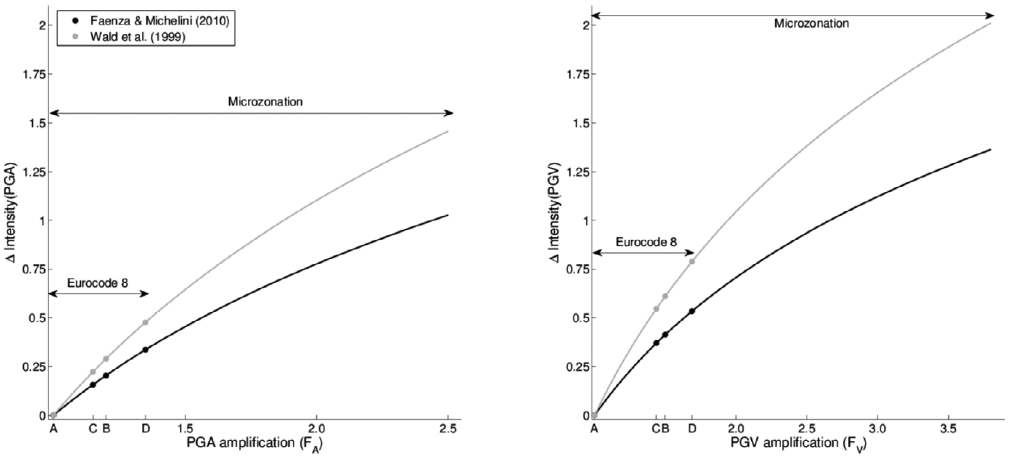
Figure 6. Effect of PGA and SA(0.5s) (proxy for PGV) site amplifications on macroseismic intensities for two GMICEs and the site factors predicted by Eurocode 8 and the microzonation of L’Aquila.